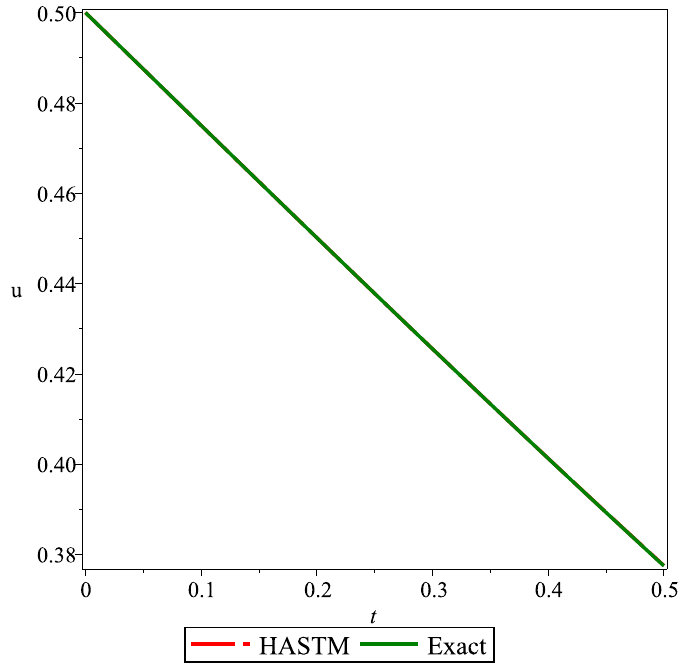
Figure 4. Plot of u ( t ) with respect to t for µ = 1.